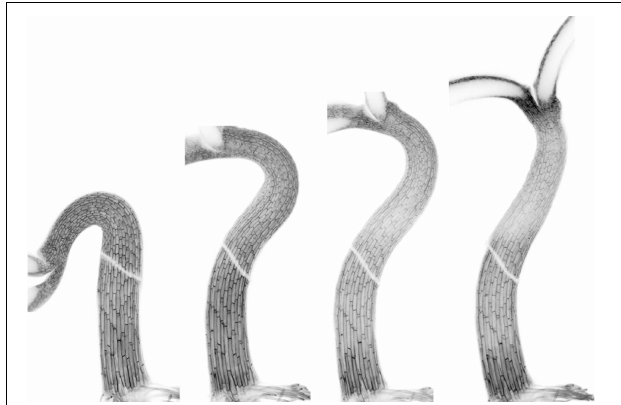
FIGURE 4 | High-resolution images of a single Arabidopsis seedling undergoing hook opening during de-etiolation. From left to right: 2-day-old dark-grown seedling at the end of the maintenance phase; the same seedling 2, 4, and 8h after illumination, respectively. The middle part of hypocotyls was removed—white oblique lines—to prepare the final images showing both the bottom and apical parts of hypocotyls. Pictures courtesy of Dr. Javier